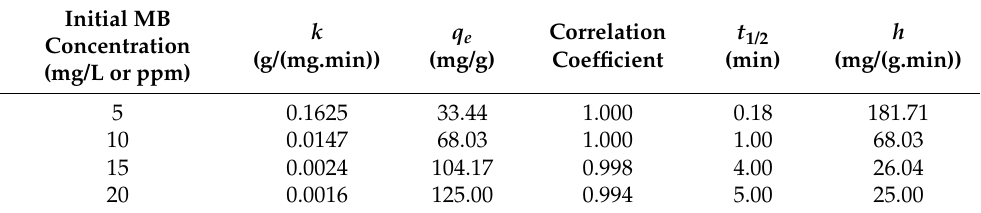
Figure 6. Variations of dimensionless concentration (C t /C 0 ) vs. time under various initial MB con- centrations (WCH-AC dosage = 0.3 g/2 L, initial pH = 7.0); symbols: experimental data, full lines: obtained from the pseudo-second-order model parameters (Table 3).